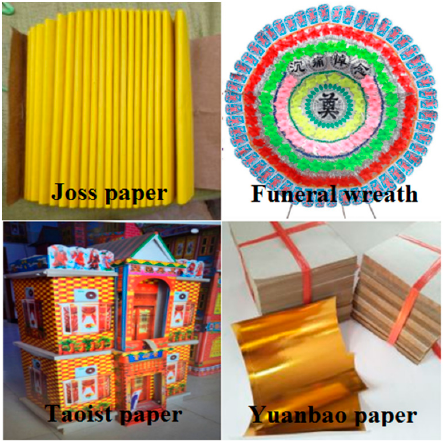
Figure 2. Four types of sacrificial offerings used in the experiment.